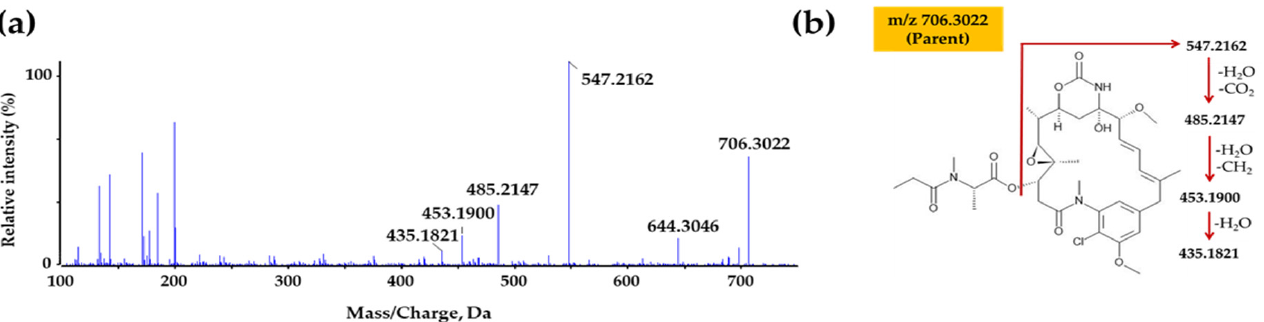
Figure 2. ( a ) MS/MS spectrum of desulfurated DM1 and ( b ) expected fragment ions of parent ion ( m / z 706.3022). The calibration curves with eight points in the range of 17.09~1709.44 ng/mL in duplicate were freshly prepared for all data sets. The quadratic regression using the ratios of peaks versus concentrations was weighted by 1/concentration. The acceptance of the curve was ≥ 0.99 for the desulfurated DM1. Figure 3 shows the calibration curve of desulfurated DM1.